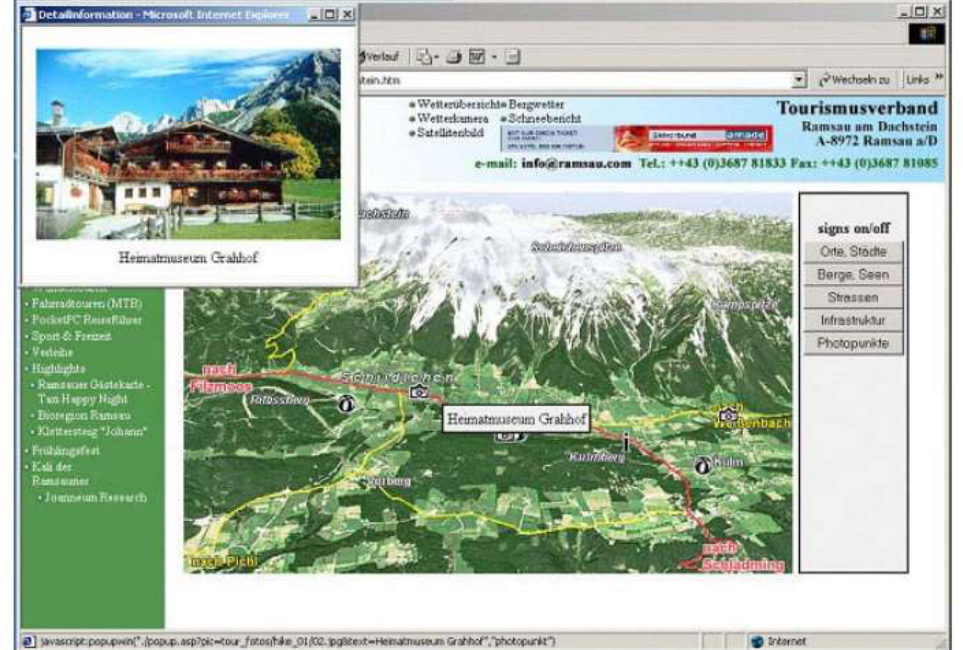
Figure 5. Display 3 Dimensions of Tourism Infrastructure (Source: Almer & Stelzl,